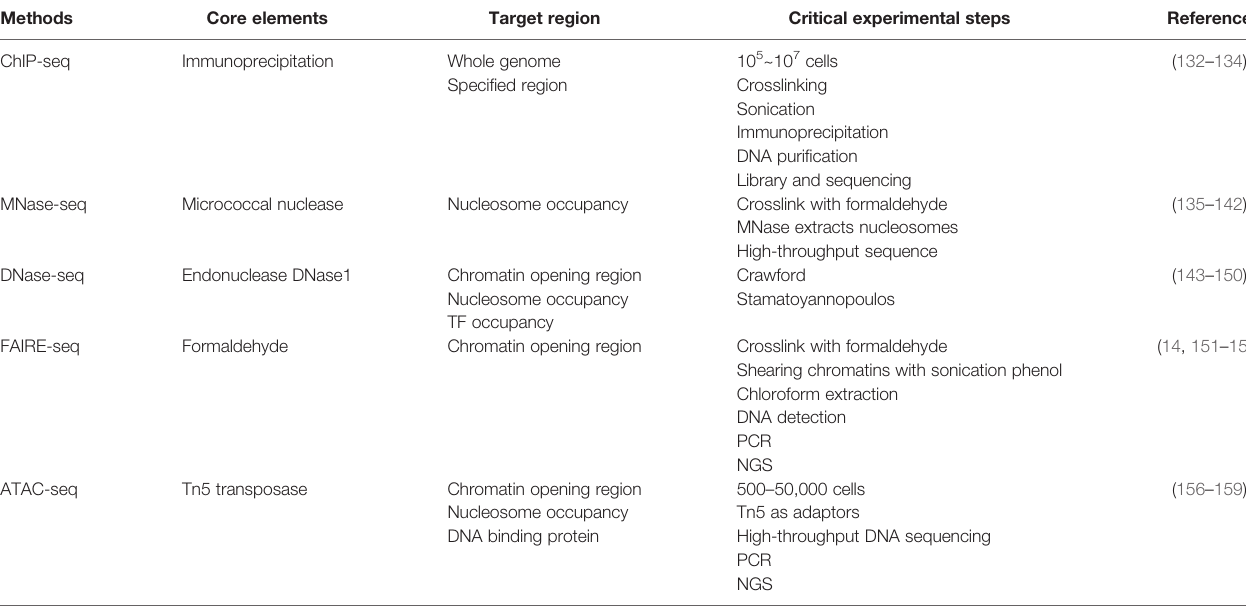
TABLE 2 | High-throughput methods for chromatin